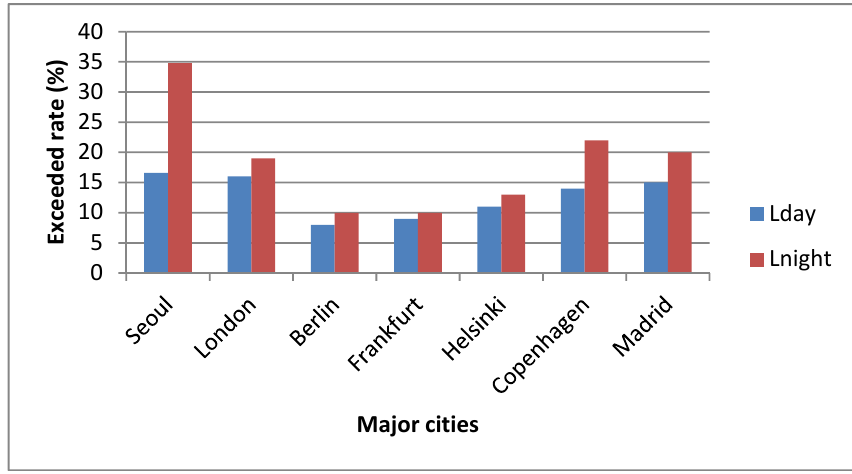
Figure 8. Comparison of exceeded rate in Seoul and major cities of the EU.